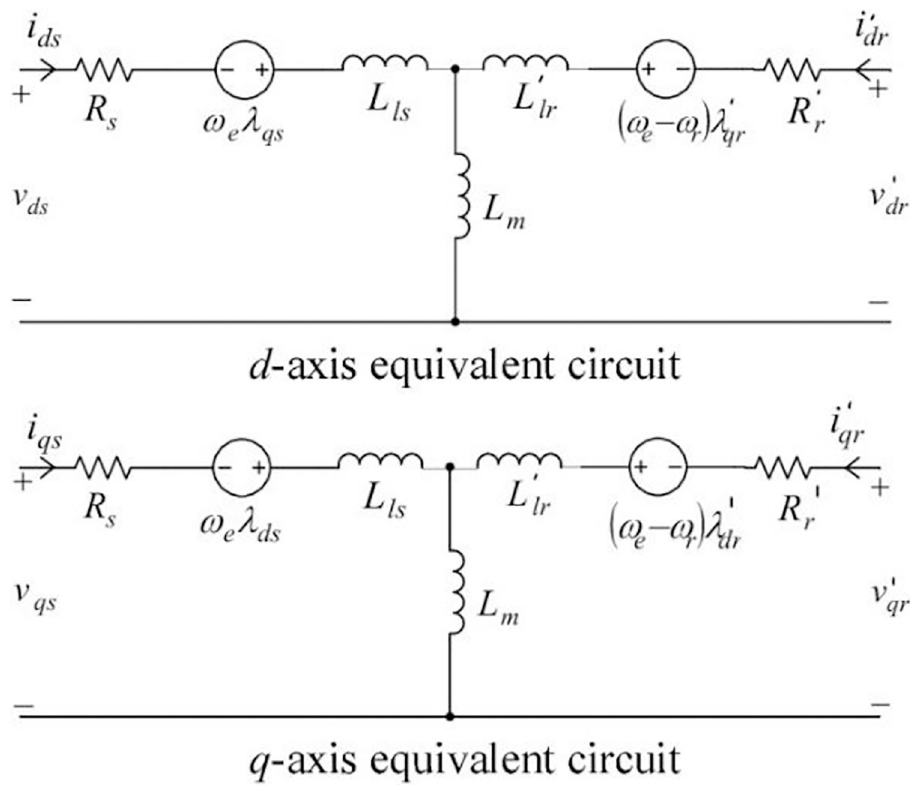
Fig 2. Equivalent circuit of DQ